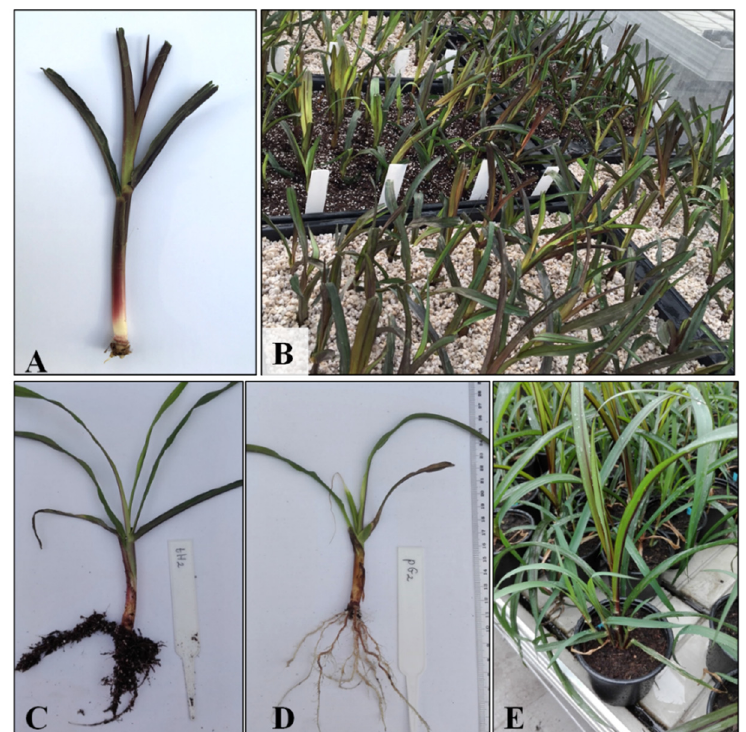
Figure 2. ( A ) prepared cutting, ( B ) cuttings placed in two different media: perlite or peat, ( C ) cutting rooted in peat, ( D ) cutting rooted in perlite, ( E ) final product obtained after 2 months of pot cultivation.